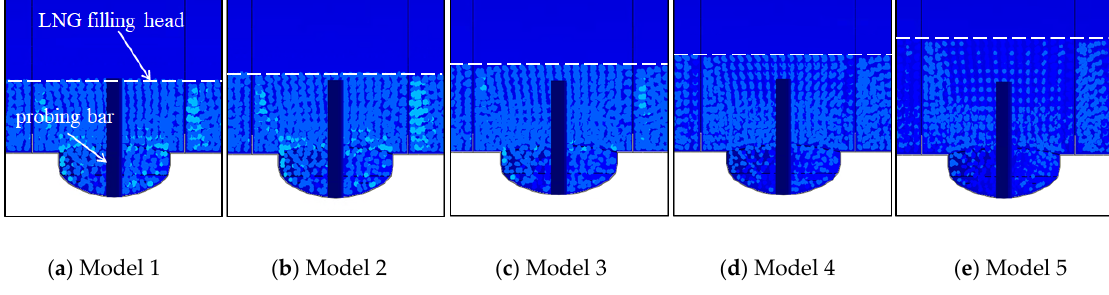
Figure 6. The filling head in each model.